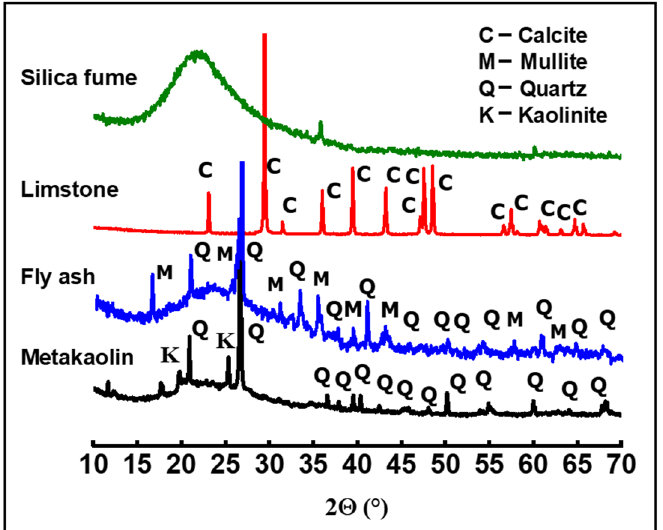
Figure 1. XRD patterns of metakaolin, fly ash, limestone, and silica fume powders. The thermal behavior of powders was studied using a DTG 60 instrument from Shimadzu (Shimadzu, Kyoto, Japan). Analyses were performed in air using a heating rate of 10 ◦ C/min. The DTA-TG curves of metakaolin and fly ash is presented in Figure 2. The thermal decomposition of fly ash occurred in two steps (Figure 2a): In the first step, the mass loss in the TG curve below 100 ◦ C can be attributed to the departure of adsorbed water. This phenomenon is associated with endothermic effects at 20–75 ◦ C in the